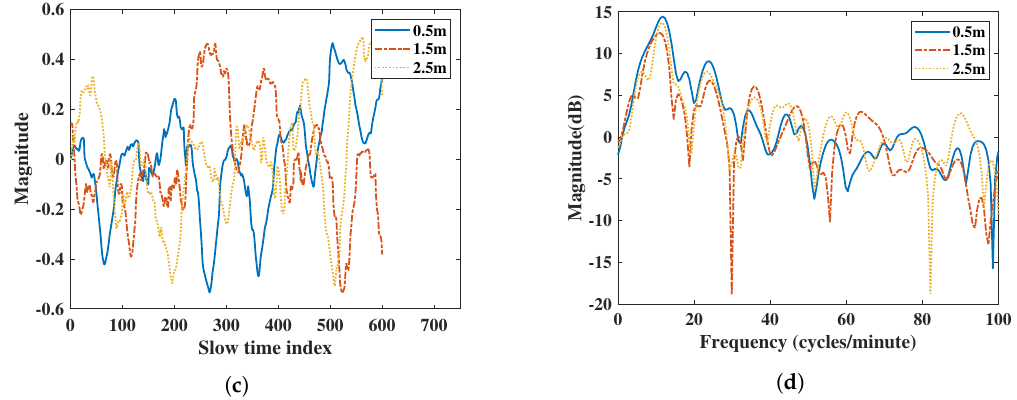
Figure 7. Vital signs extracted using FMCW radar at 0.5 m, 1.5 m, and 2.5 m: ( a ) vital signs extracted by IR-UWB radar in the time domain, ( b ) vital signs extracted by IR-UWB radar in the frequency domain, ( c ) vital signs extracted by FMCW radar in the time domain, ( d ) vital signs extracted by FMCW radar in the frequency domain.